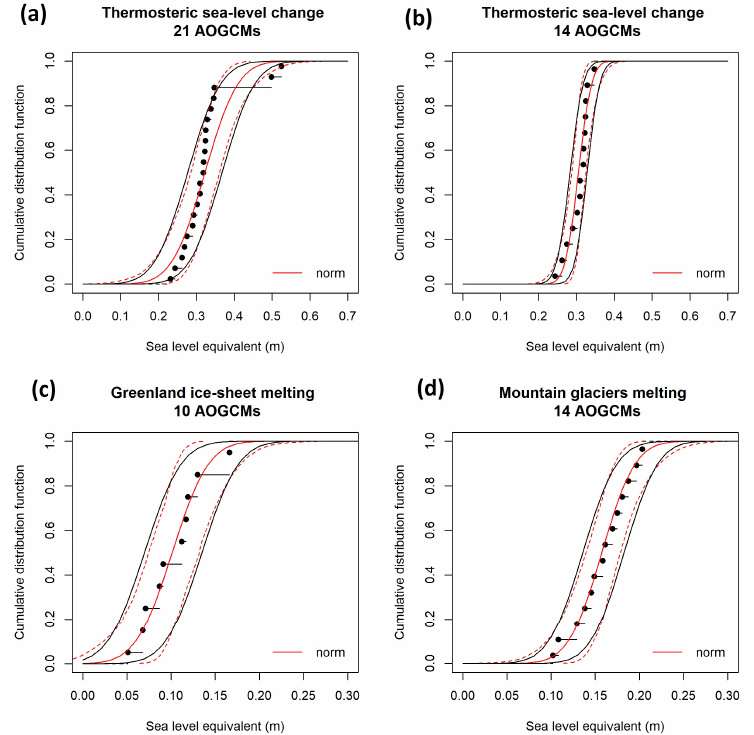
Figure 3. Bootstrap analysis (using 1000 random replicates) of the Gaussian assumption of contributions to sea-level rise in 2099 for RCP8.5. ( a ): 21 models used in AR5 (regional results); ( b ): subset of models used in this study; ( c ): Greenland [10]; ( d ): Mountain glaciers [41]. Black dots correspond to the empirical cumulative distribution function and the solid red curve is its Gaussian fit. Dashed red curves indicate maximum and minimum empirical cumulative distributions delivered by the bootstrap procedure. Solid black curves indicate the maximum and minimum Gaussian fits. This figure allows estimating the potential error made with Gaussian assumptions in this study.